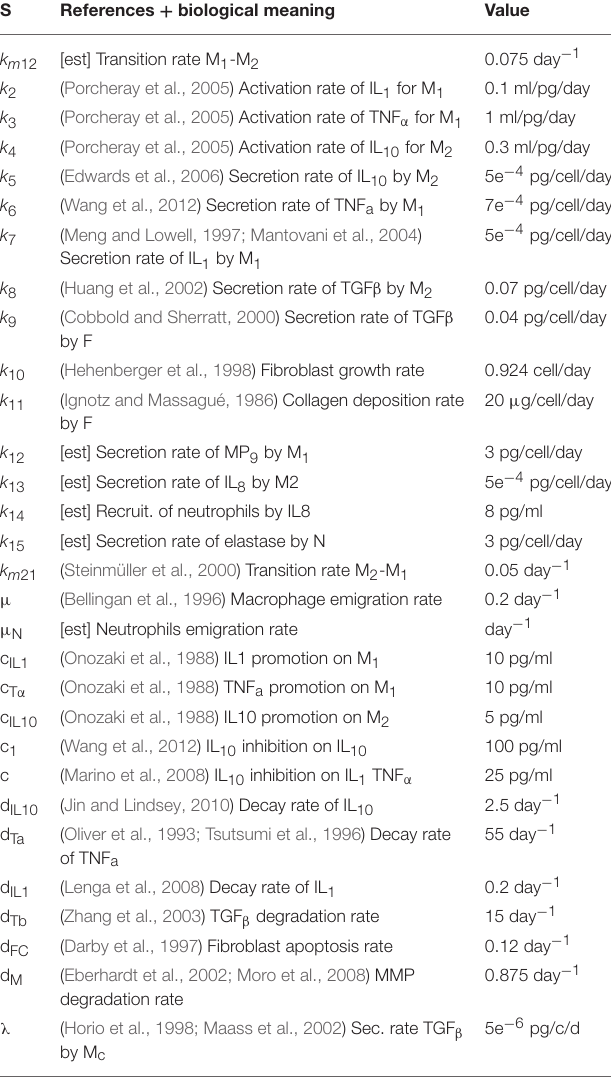
TABLE 1 | Parameters of the AB